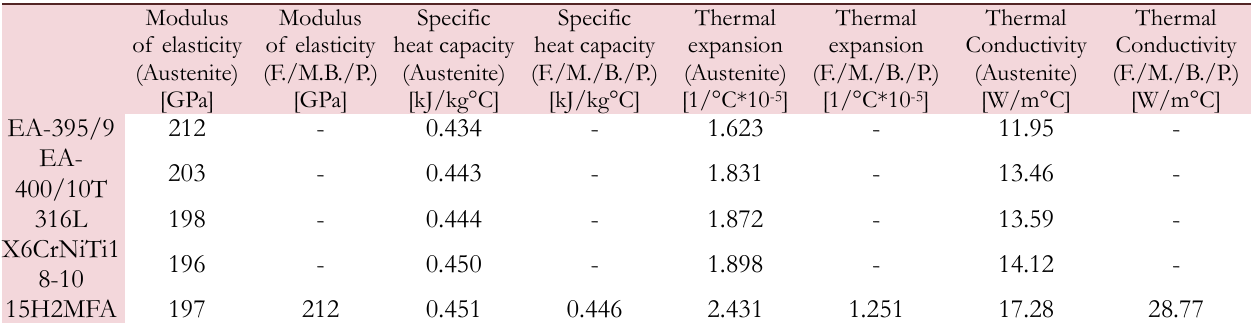
Table 6: Thermo-mechanical properties at room